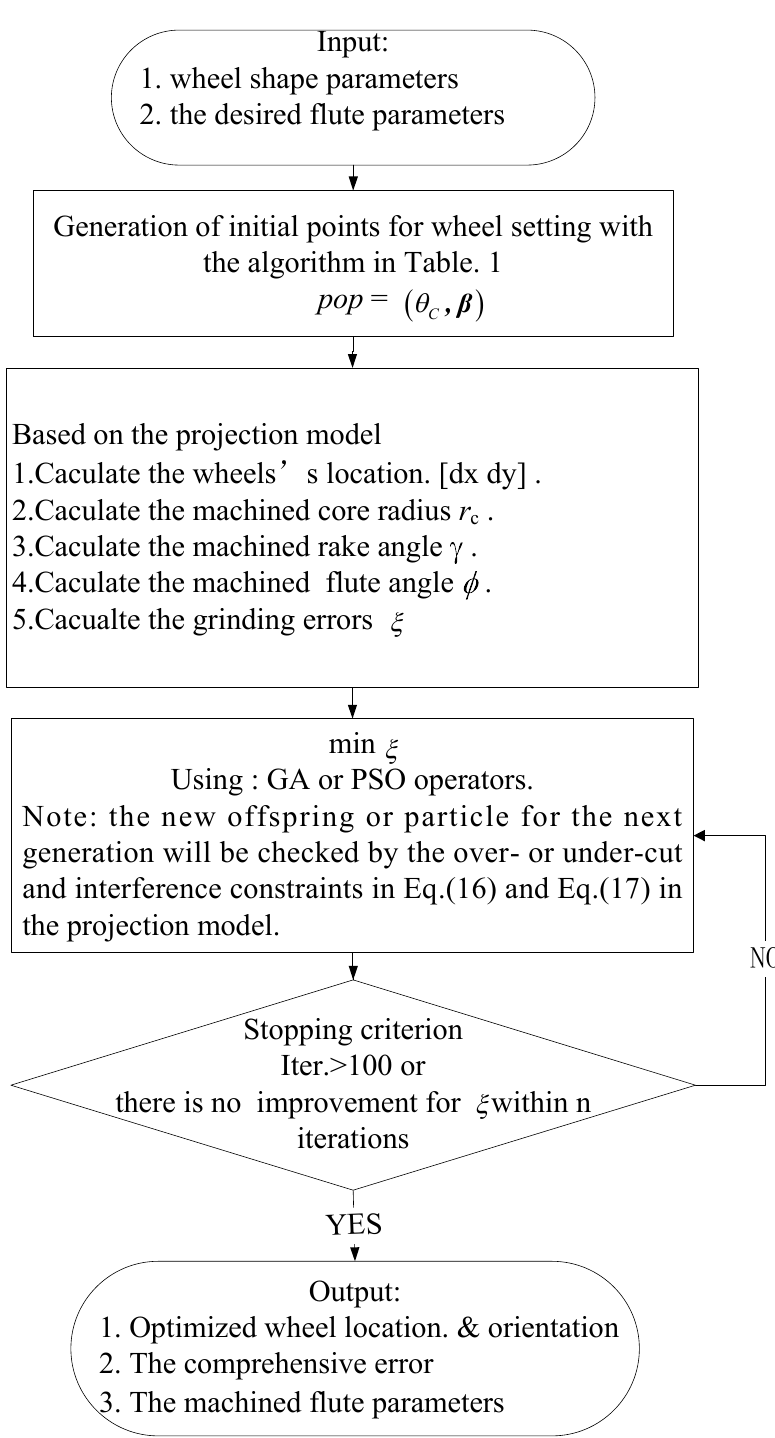
Figure 6. Flow chart of the improved genetic algorithm (IGA) and improved particle swarm Figure6. Flowchartoftheimprovedgeneticalgorithm(IGA)andimprovedparticleswarmoptimization optimization (IPSO) with the projection model. (IPSO) with the projection